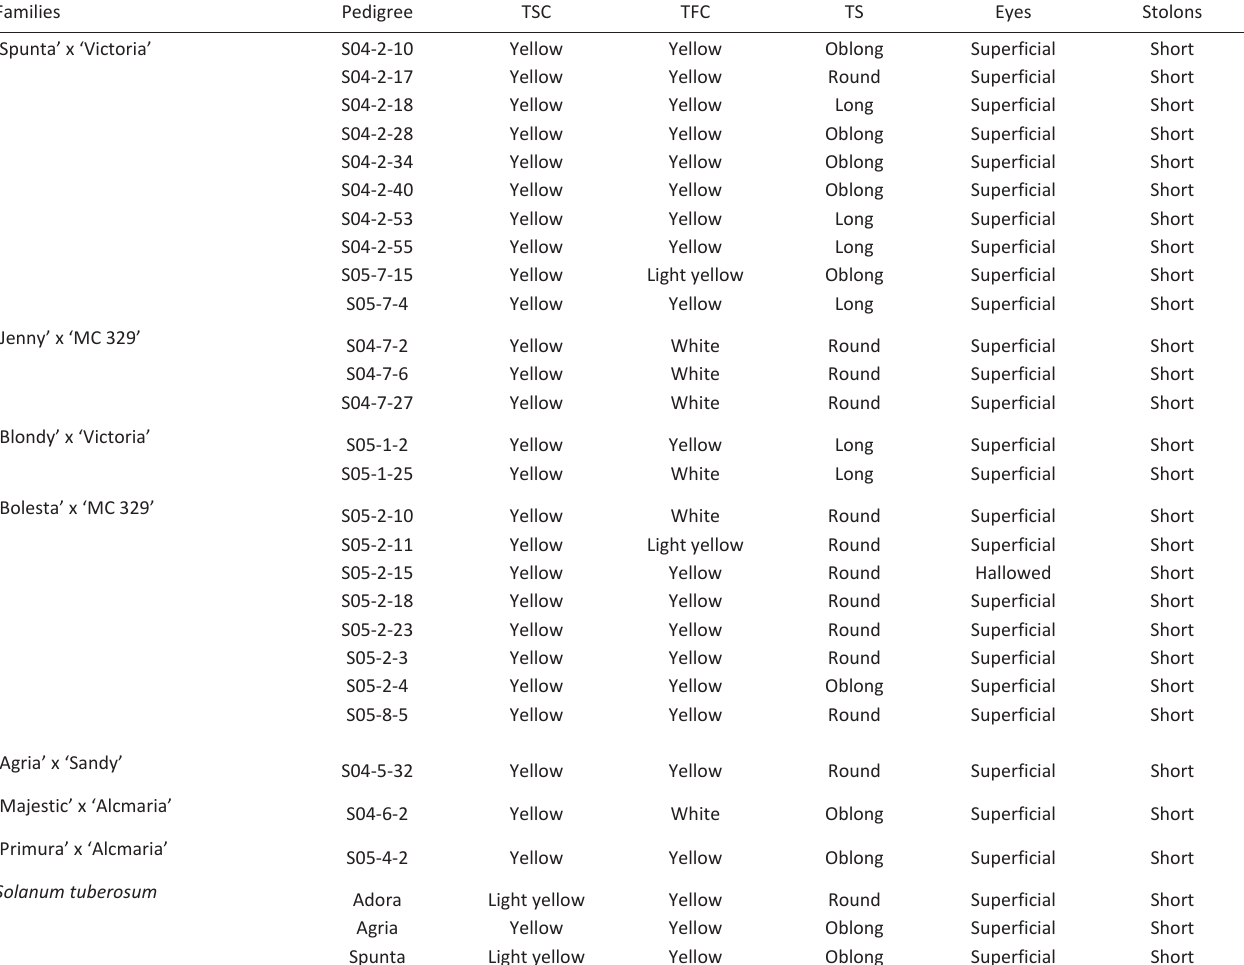
table 1 - tuber characteristics of the potato clones under selection. For each clone, pedigree, tuber skin color (tSC), tuber flesh color (tFC), tuber shape (tS), eye and stolon characteristics are reported. Families pedigree ‘Spunta’ x